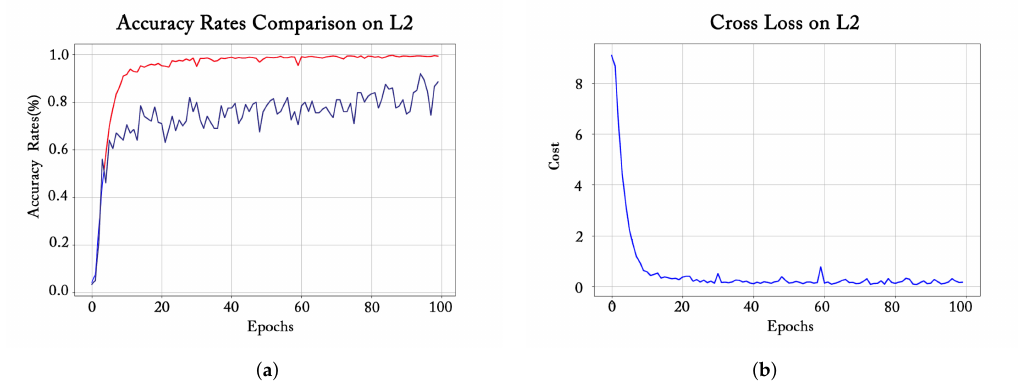
Figure 8. Training accuracy, validation accuracy, and training loss during L2 model training. ( a ) Ac- curacy comparison. ( b ) Cross loss.